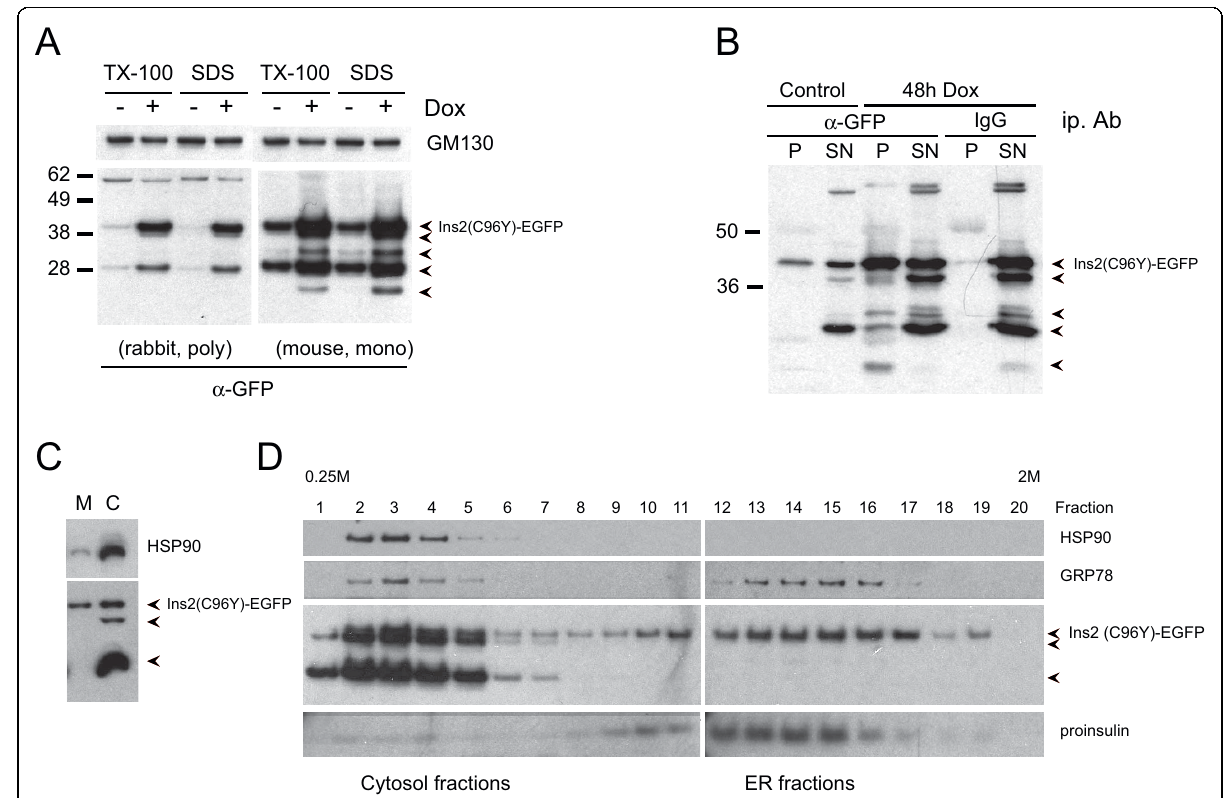
Figure 2 Insulin 2 (C96Y)-EGFP is localized to the ER while degradation products appear in the cytosol . A . Clone #4S2 cells were untreated (-Dox) or treated with 2 μ g/ml doxycycline (+Dox) for 48 h. Following the treatments, the cells were washed in PBS and lysed in either 1% TX-100 lysis buffer (with protease inhibitors) or directly in SDS sample buffer with b -mercaptoethanol. Equal amounts of protein (or equal volumes) were resolved by SDS-PAGE and immunoblotted using antibodies to GM130 or GFP. B . Cells were untreated (Control) or treated for 48 h with 2 μ g/ml doxycycline before lysis and immunoprecipitation with anti-GFP or control mouse IgG antibodies. The entire precipitate (pellets; P) and 10 μ g of the supernatant (SN) were resolved by SDS-PAGE and immunoblotted using an anti-GFP (rabbit, polyclonal) antibody. C . Cells were treated with 2 μ g/ml doxycycline for 72 h, washed in PBS and homogenized in sucrose buffer as described in the methods. The homogenate was fractionated into membrane (M) and cytosol (C) fractions. D . Cells were treated with 2 μ g/ml doxycycline for 72 h, washed in PBS and homogenized in sucrose buffer as described in the methods. The homogenate was fractionated on a linear sucrose density gradient and an equal volume of each fraction was resolved by NuPAGE and immunoblotted using antibodies to HSP90, GRP78, GFP and